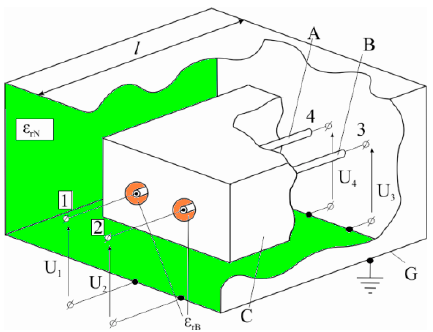
Figure 1. reentrant structure as a four-port network. A, B, C: conductors; G: ground conductor.